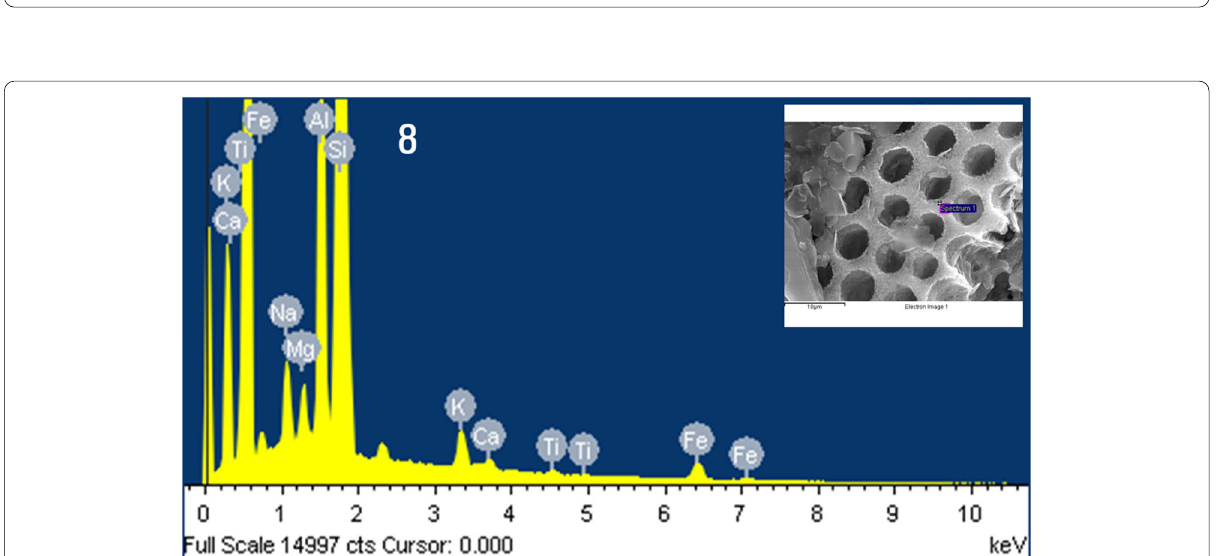
Fig. 8 Energy-dispersive X-ray spectroscopy (EDS) spectrum of the diatom frustule. EDS reveals that Si, Al, Fe, K, Na, Mg, and Ti elements are present on the diatom frustule. Inset: Scanning electron micrograph of the mud powder displaying the detection area of the EDS spot